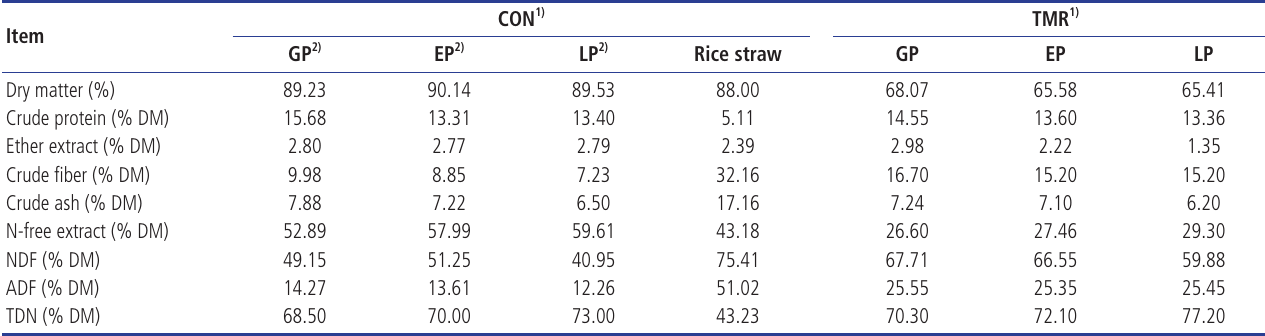
Table 2. Chemical composition of experimental diets